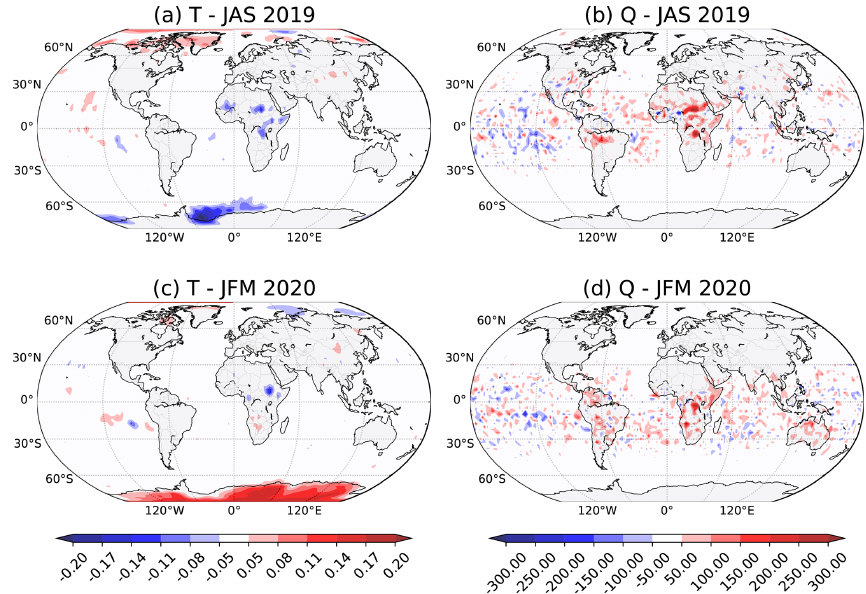
Figure 7. Time average difference between the SKTECV and the TOVSCV analyses at 850hPa for (a, b) JAS 2019 and (c, d) JFM 2020 for (a, c) the temperature (in K) and (b, d) the specific humidity (in µgg − 1 ). Note that when the 850hPa level is below the surface, the lowermost model level is